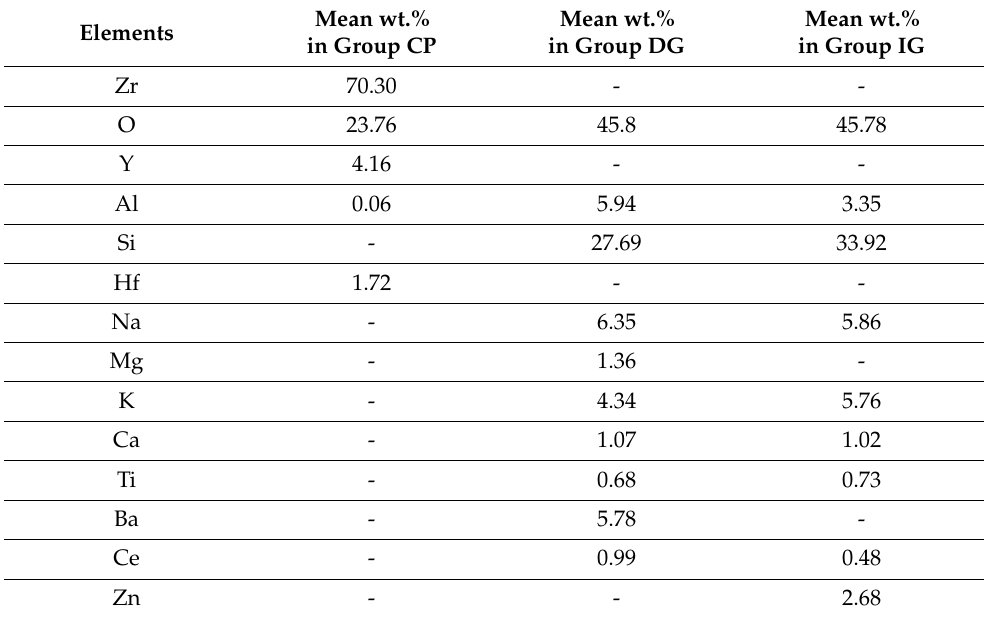
Table 5. Mean value (wt.%) of elements present on the surfaces on control and glazed specimens.